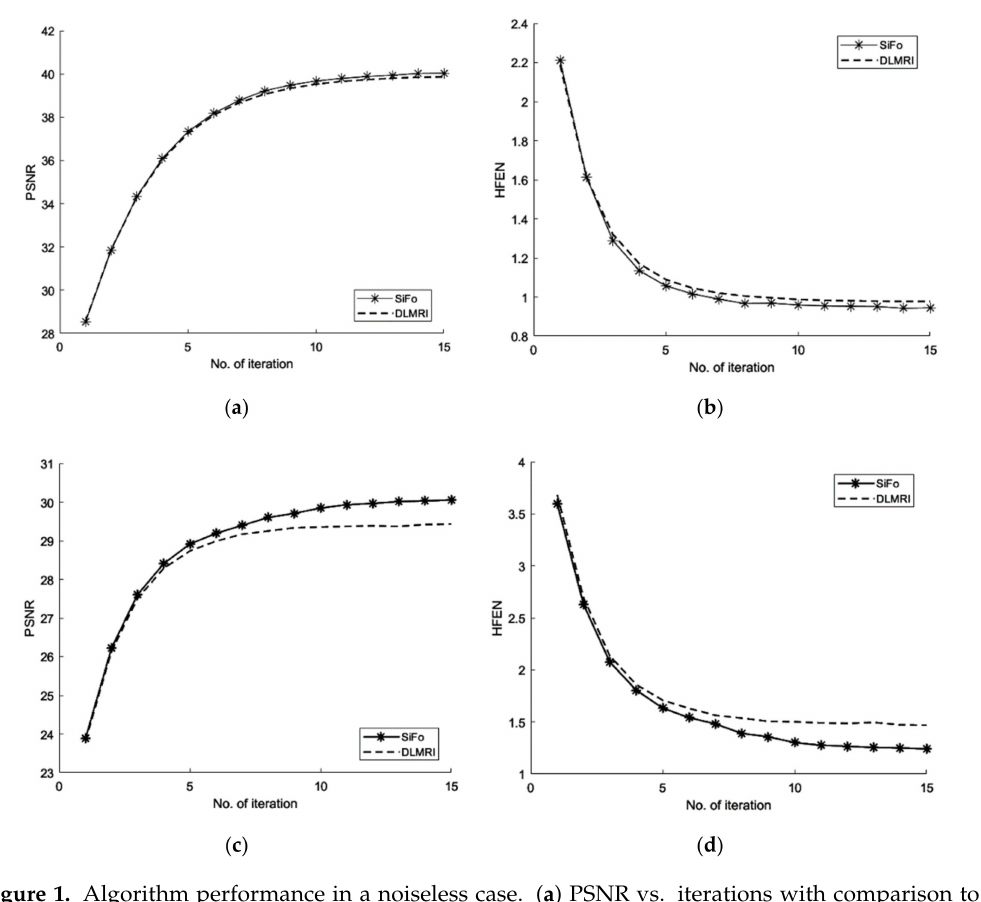
Figure 1. Algorithm performance in a noiseless case. ( a ) PSNR vs. iterations with comparison to DLMRI for a brain image; ( b ) HFEN vs iterations with comparison to DLMRI for a brain image; ( c ) PSNR vs iterations with comparison to DLMRI for a phantom image; ( d ) HFEN vs. iterations with comparison to DLMRI for a phantom